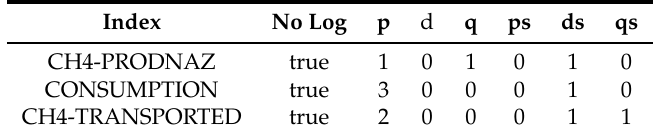
Table A3. Synthesis of Seasonal Arima used for energy at daily